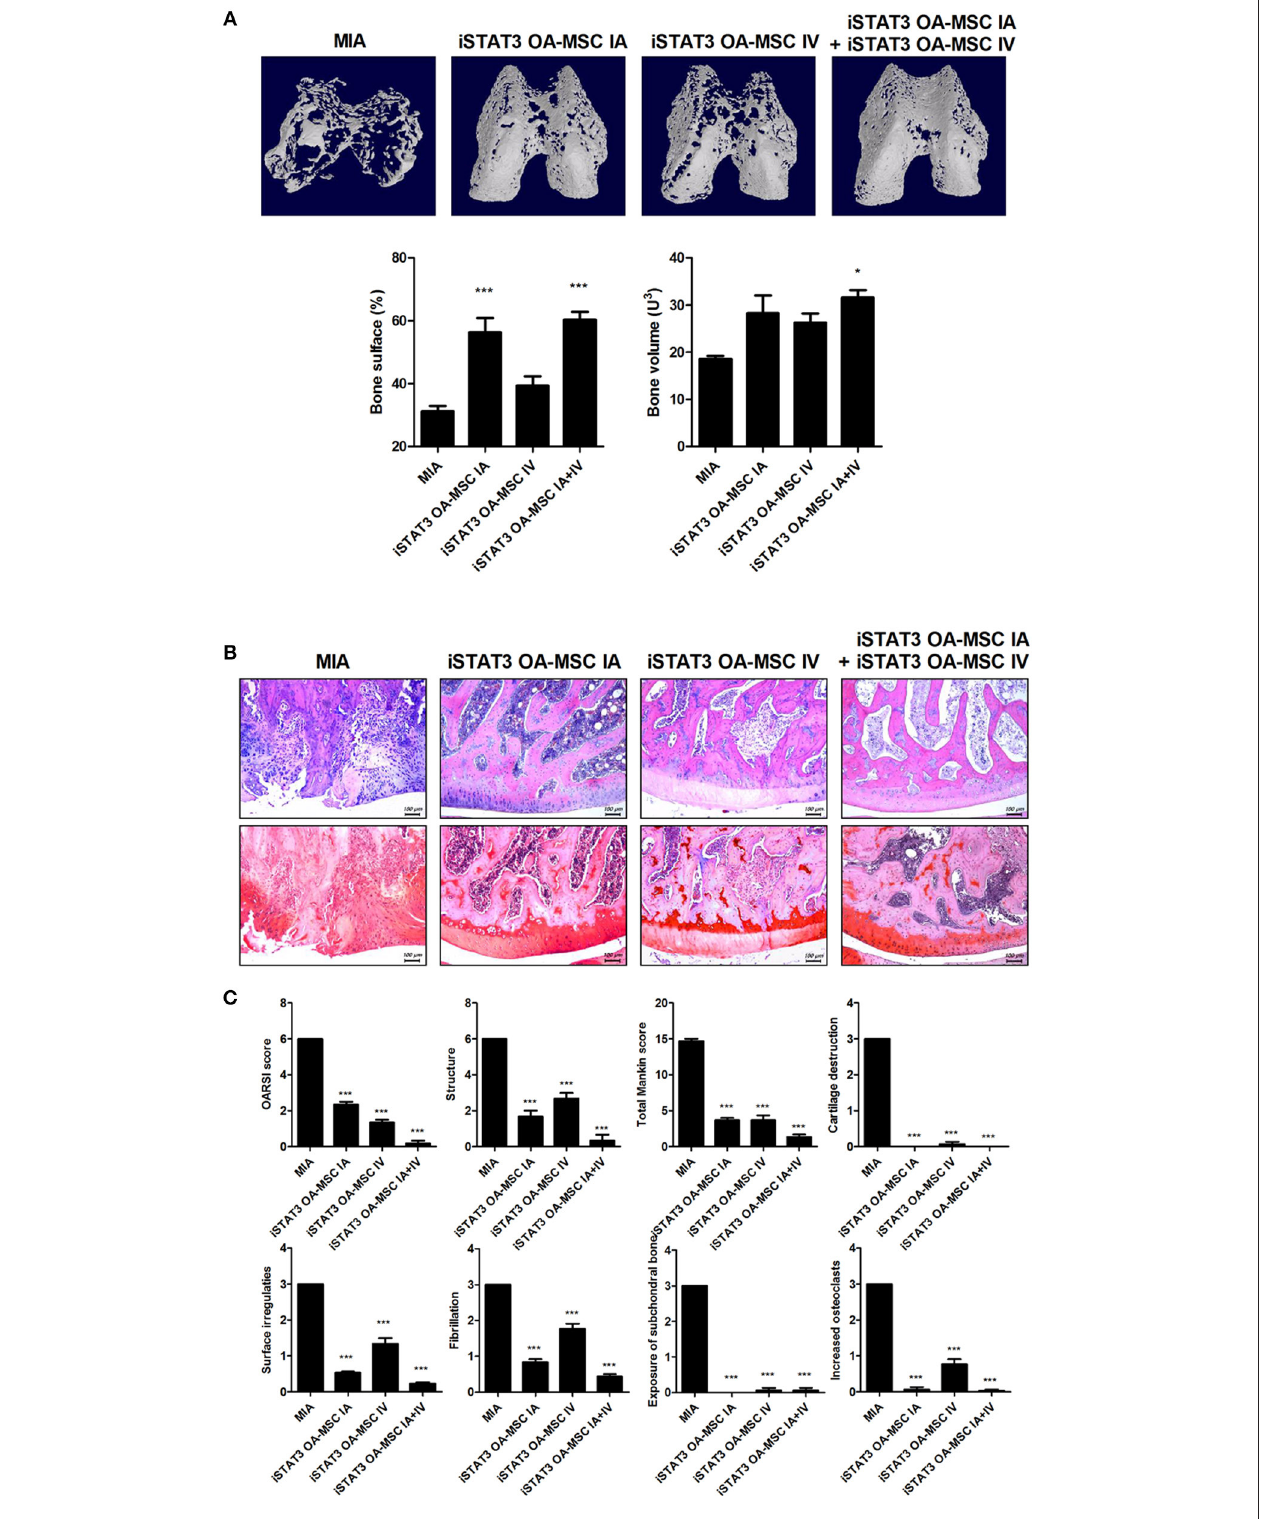
FIGURE 5 | Additive effect of IA and IV co-administration of iSTAT3 OA-MSCs on joint protection in MIA-induced OA rats. (A) Representative micro-CT images of the femoral condyles at 4 weeks in all groups. Object volume (Obj.V) and bone surface (%) from micro-CT images of the femur (* P < 0.05, *** P <